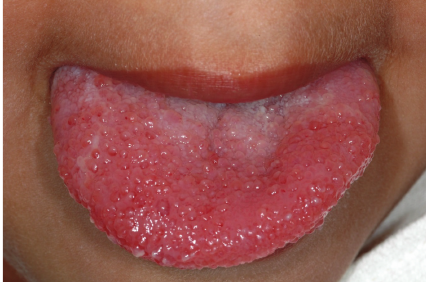
Figure 3: Clinical photograph of grossly enlarged papillae on the anterior one-third of the